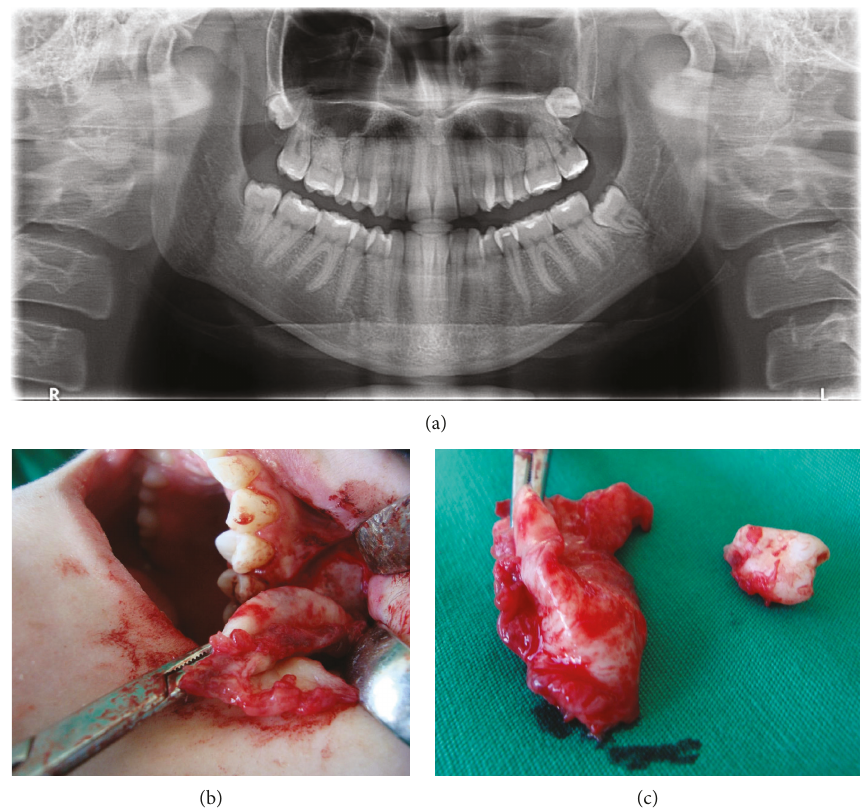
Figure 4: (a) OPG image showing a highly impacted 28 with opaci fi cation of the left maxillary sinus. (b) Enucleation of a huge cystic capsule. (c) Macroscopic preparation of a cystic capsule and extracted impacted